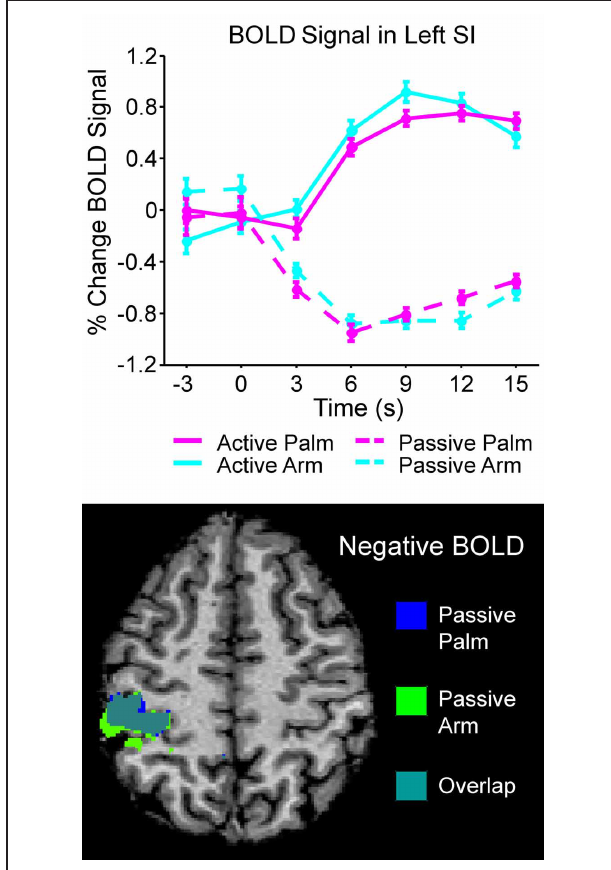
FIGURE 3 | Overview of the left SI area that showed significant negative BOLD during passive stroking. The top graph shows the time courses of all the conditions in the left SI BA03 area (see Table 1 for more details); in active touch, there was a significant positive BOLD signal changes, whereas in passive touch, there was a significant negative BOLD signal. The bottom panel shows the negative BOLD signal areas for passive touch to the palm and arm; these regions overlapped greatly. The brain map in the bottom panel is to neurological convention (left is